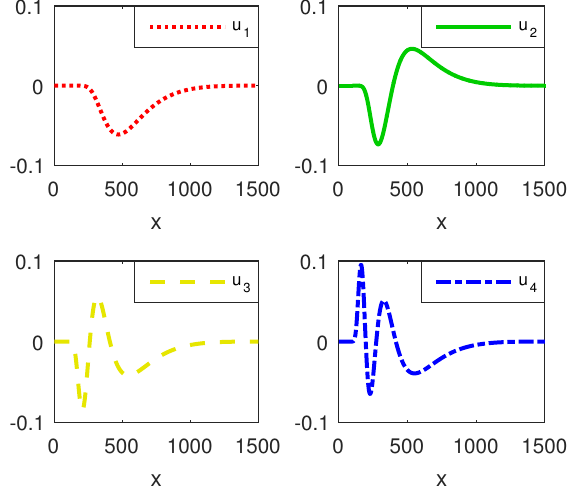
Figure 7. The first four eigenvectors for the hydrogen atom eigenproblems (1), (5), and (6) with l : = 1 computed by mapped ChC with scaling factor c : = 2 and N : = 512.